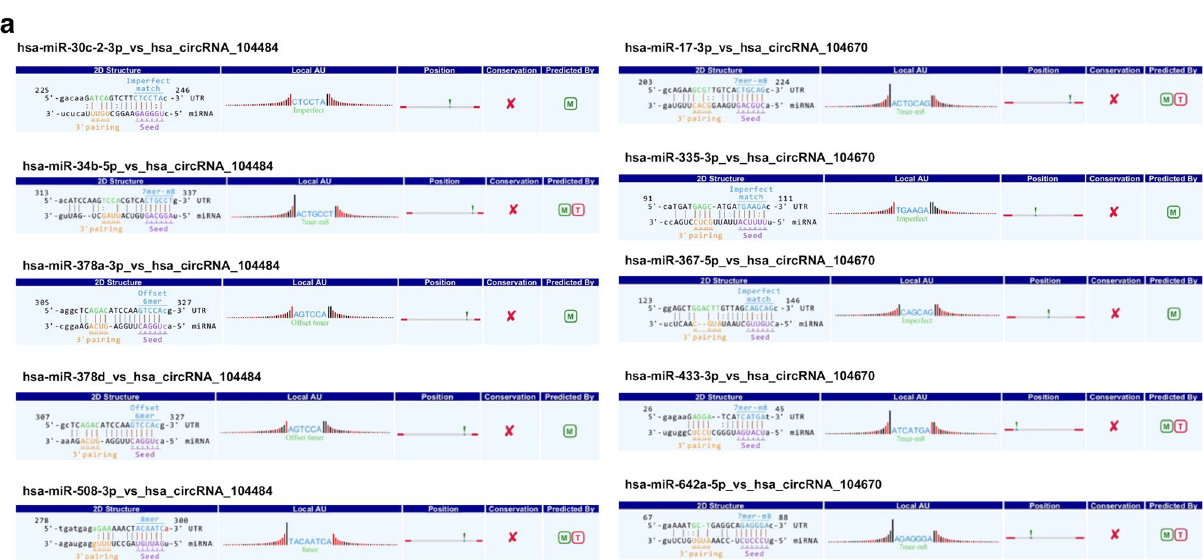
Figure 6. Prediction of circRNA-miRNA-mRNA regulatory relationship. ( a ) Annotation of detailed regulatory relationship between hsa_circRNA_104484, hsa_circRNA_104670 and miRNAs. ( b ) circRNA ‐ miRNA ‐